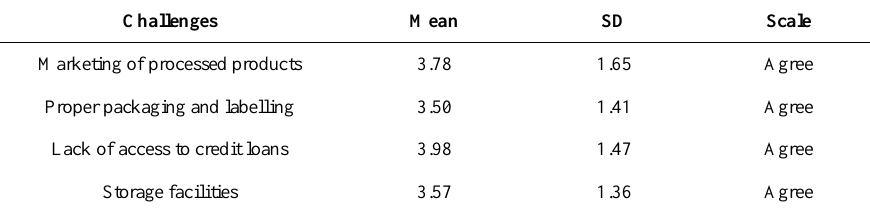
Table 4. Challenges faced by smallholder farmers in value addition of Irish potato Challenges